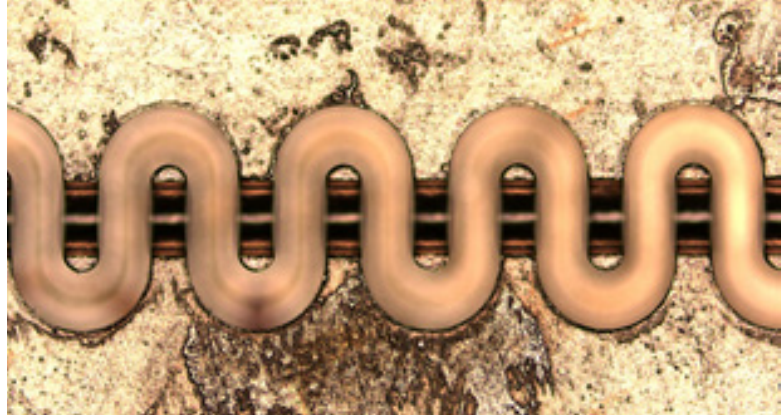
Figure 4. The fabricated circular of the folded waveguide slow-wave structure. Figure 5 shows the dispersion curves of a traditional folded waveguide circuit. For traditional fold waveguide slow-wave structure, n = − 1 forward branch of the dispersion curve was used for the circuit, which operated as usual.